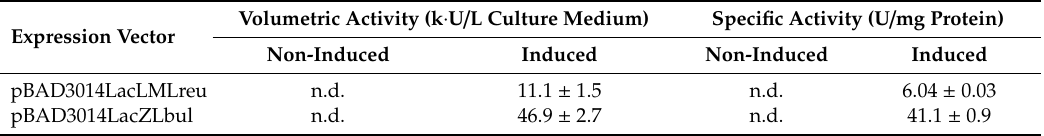
Table 1. β -Galactosidase activities in cell-free lysates of E. coli cells carrying di ff erent expression vectors.